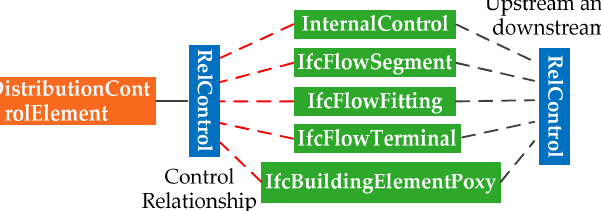
Figure 13. The topological connection relationship of the IFC instance of the MEP element.